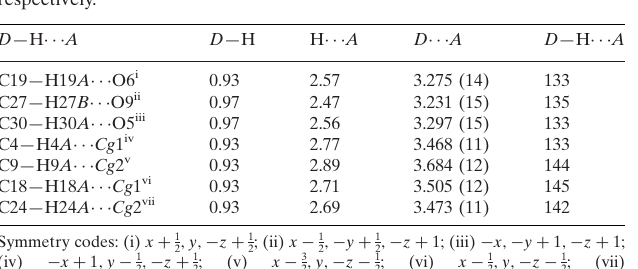
Hydrogen-bond geometry (A˚ , (cid:5)